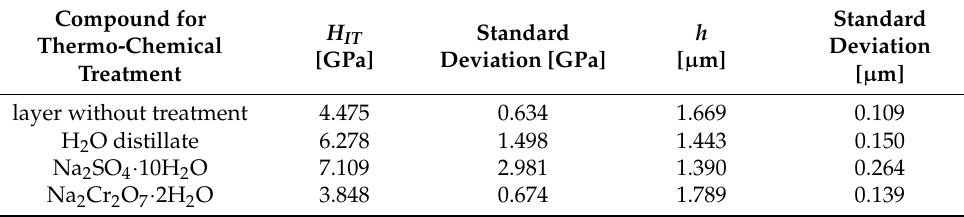
Table 4. Microhardness of studied layers and maximum indentation depth. Compound